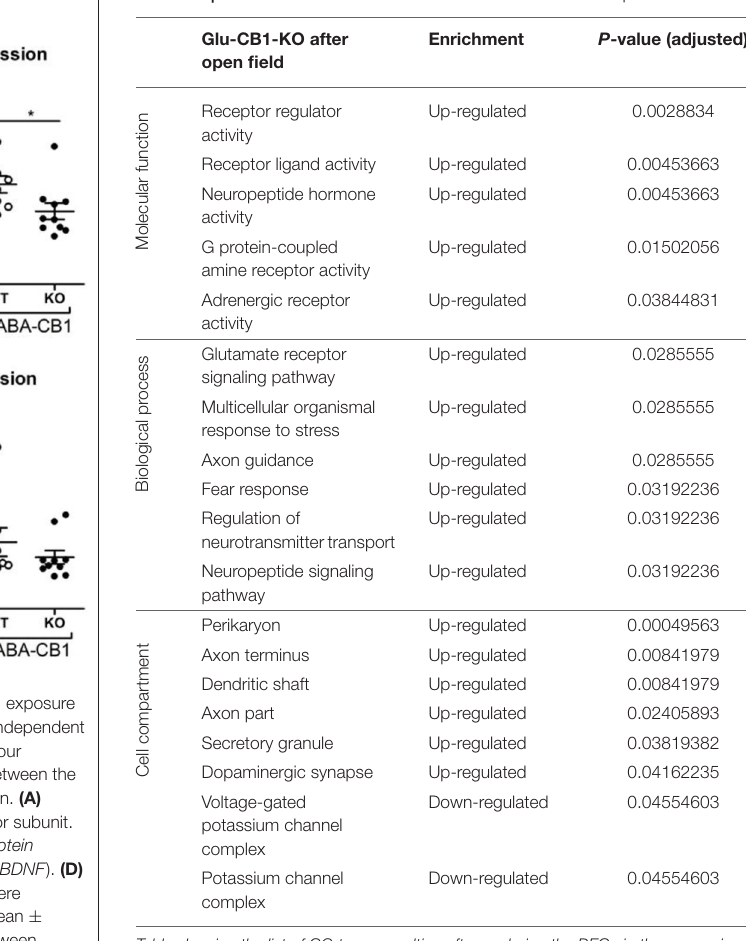
TABLE 3 | GO terms of the DEGs from Glu-CB1-KO mice after open field.